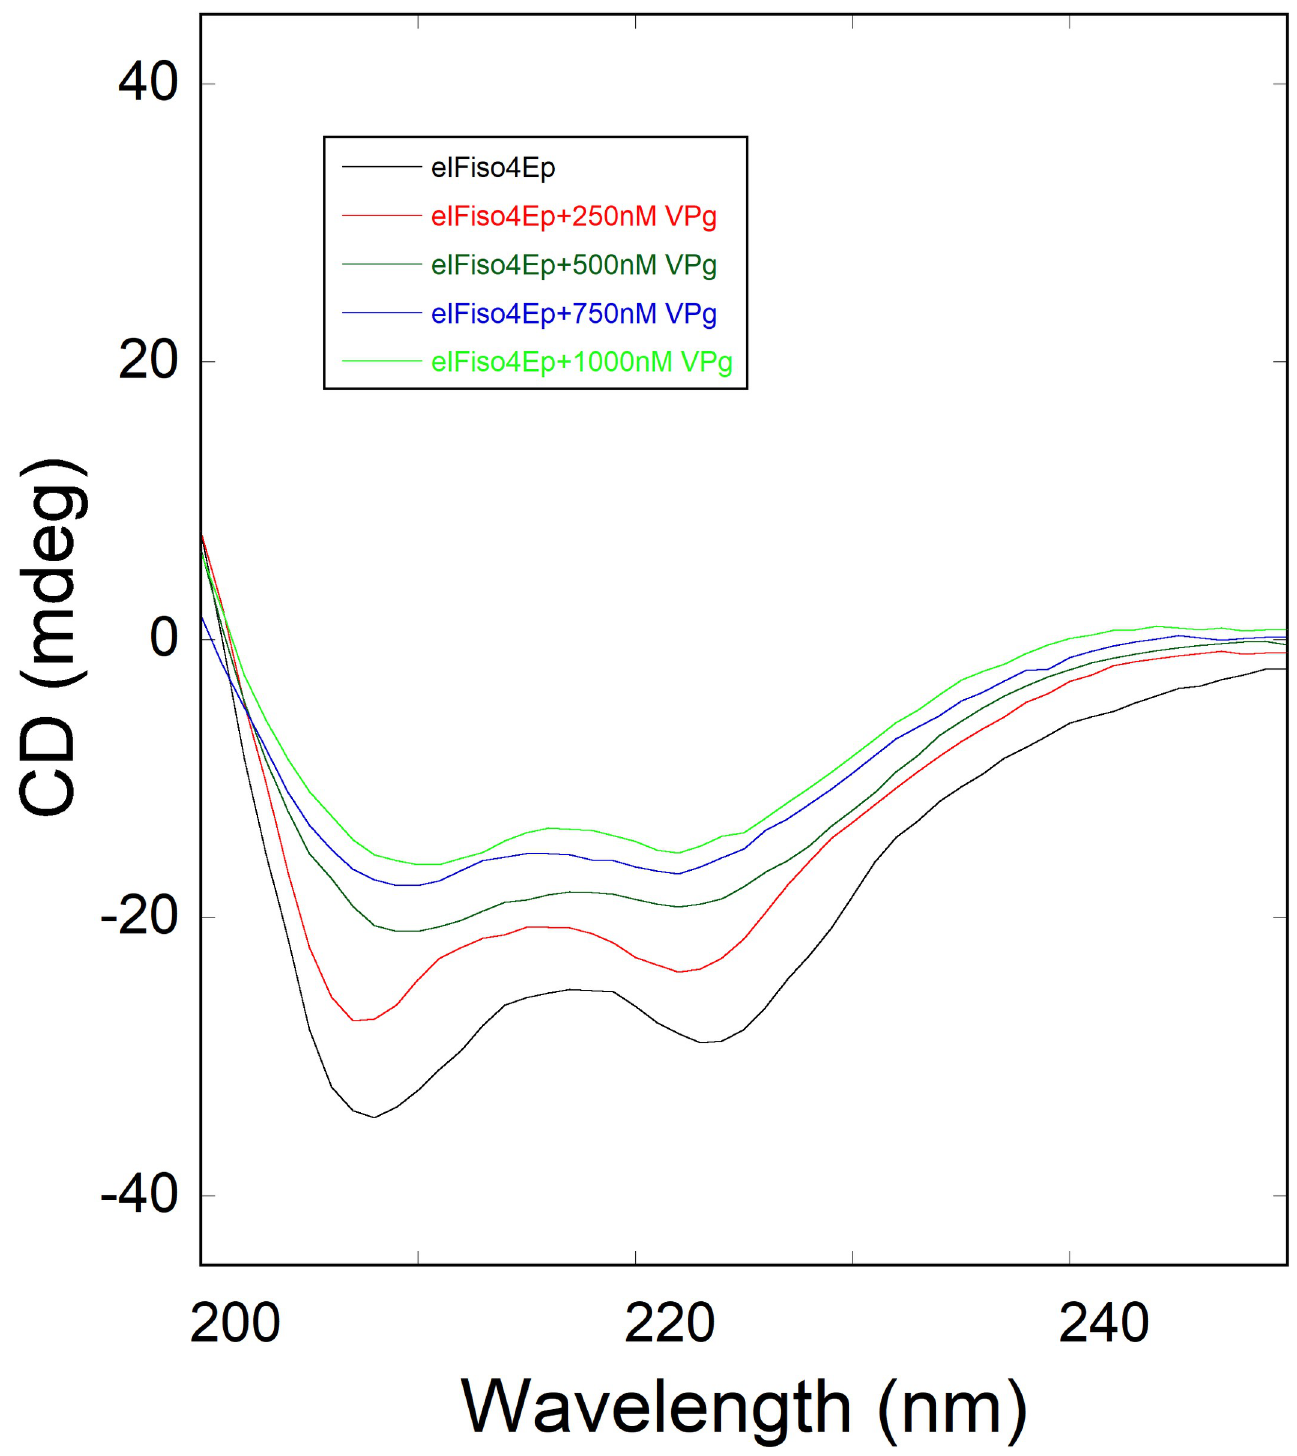
Fig 6. Far-UV CD spectra of phosphorylated eIFiso4E as a function of VPg. Far-UV CD spectra were obtained using eIFiso4Ep concentration of 0.1 μ M with addition of varying concentrations of VPg (0–1000 nM).